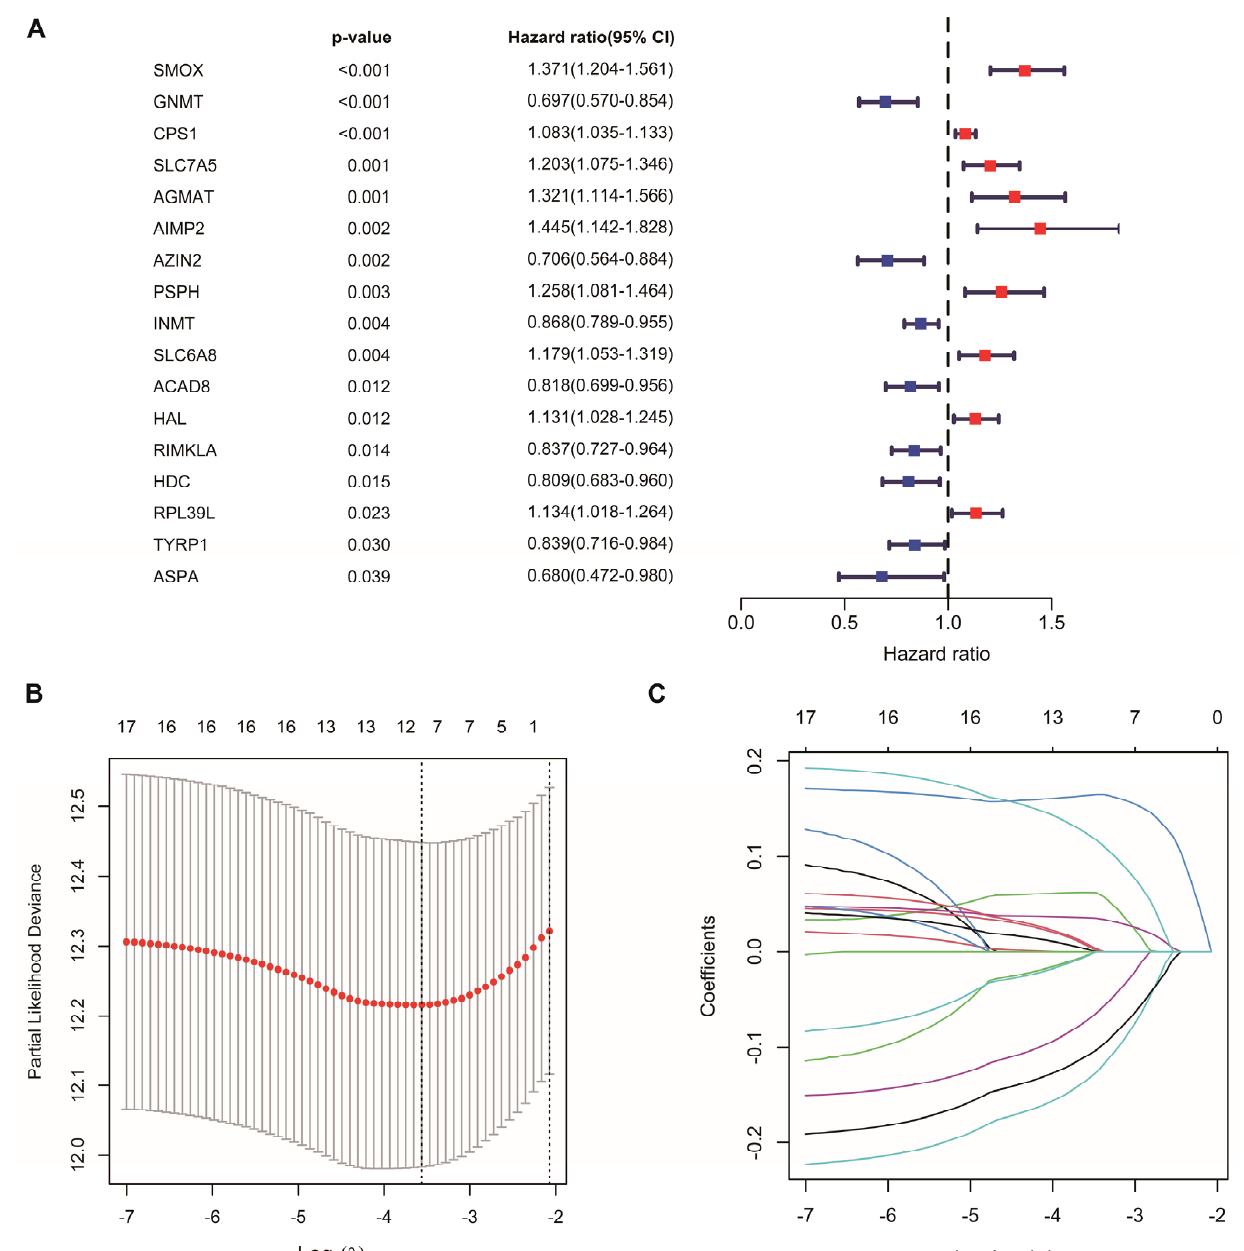
Figure 2. Construction of AAM-related gene signature for LUAD. ( A ) Univariate Cox regression analysis identifying prognostic-related genes. ( B ) Tenfold cross-validation in LASSO model. ( C ) LASSO coefficients of 17 prognostic-related genes.